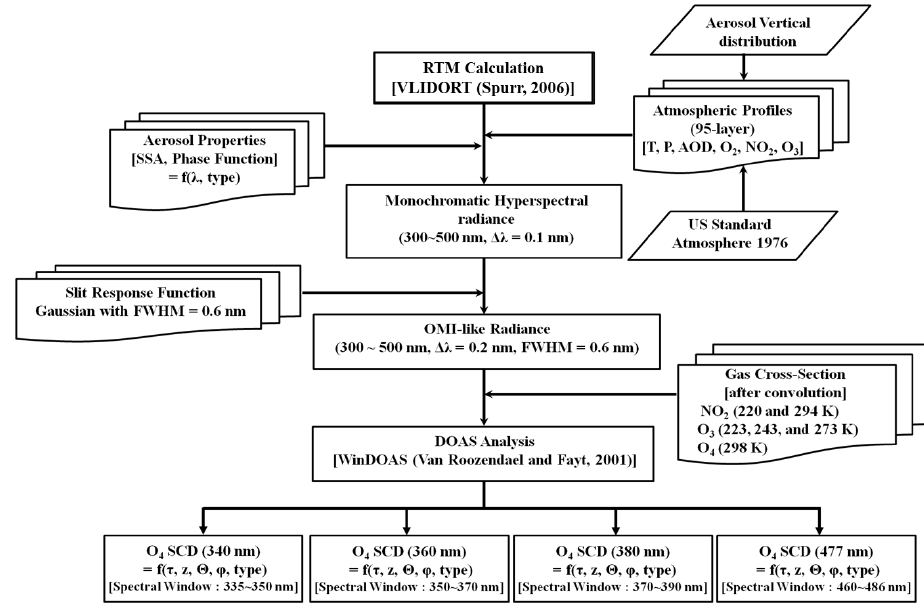
Figure 1. Flowchart of the simulated O 4 SCD estimation.